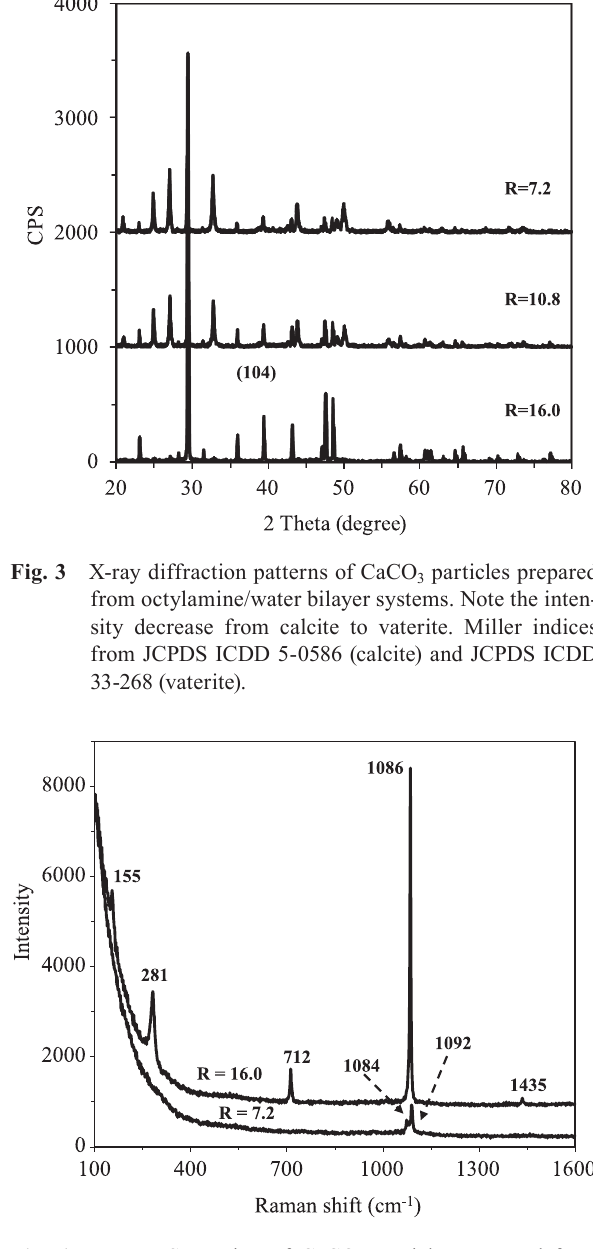
Fig. 4 Raman Scattering of CaCO 3 particles prepared from octylamine/water bilayer systems. The excitation line wavelength is 514 nm (Ar + laser). Only the two most intense bands were observed in tabular CaCO 3 vaterite due to poor